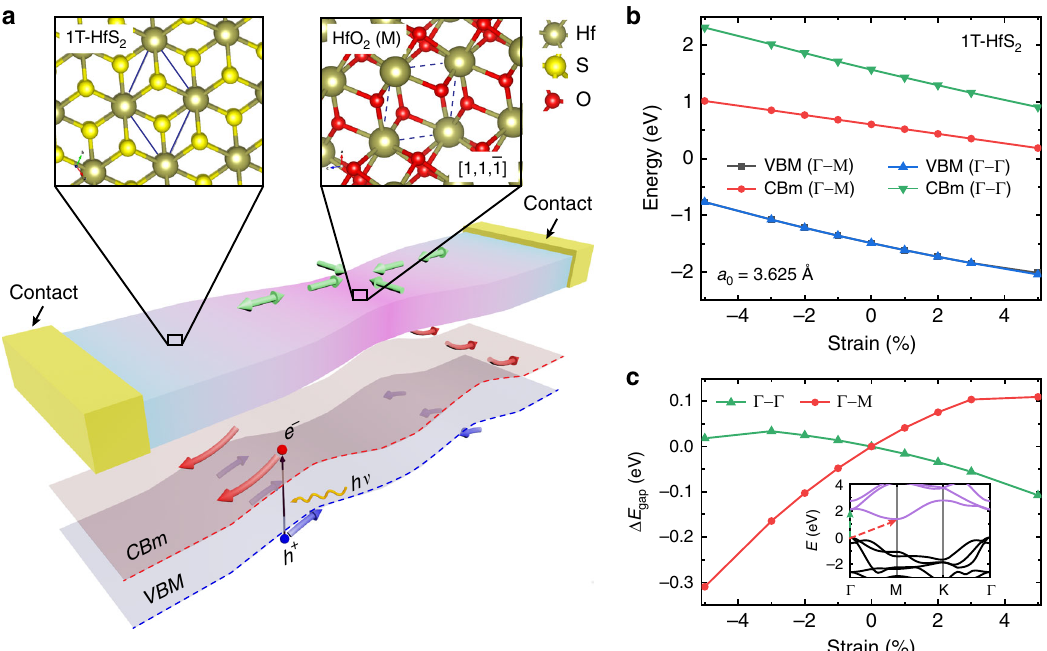
Fig. 1 Inverse charge funnelling in strained HfS 2 . a Schematic diagram of the proposed device (see Fig. 4 for the actual implementation). Compressive strain is induced in the centre of a semiconducting HfS 2 channel by controlled photo-oxidation. The compression induces tensile strain away from the HfS 2 /HfO 2 interface, resulting in the spatial modulation of the bandgap. b Ab initio calculations of the valence band maximum (VBM) and conduction band minimum (CBm) of 1T-HfS 2 as a function of strain in the Γ → Γ (direct gap) and Γ → M (indirect gap) directions. c Change in bandgap as a function of strain in the two directions, with respect to the unstrained bandgap (relaxed lattice constant a 0 = 3.625 Å). Inset: calculated band structure of 1T-HfS